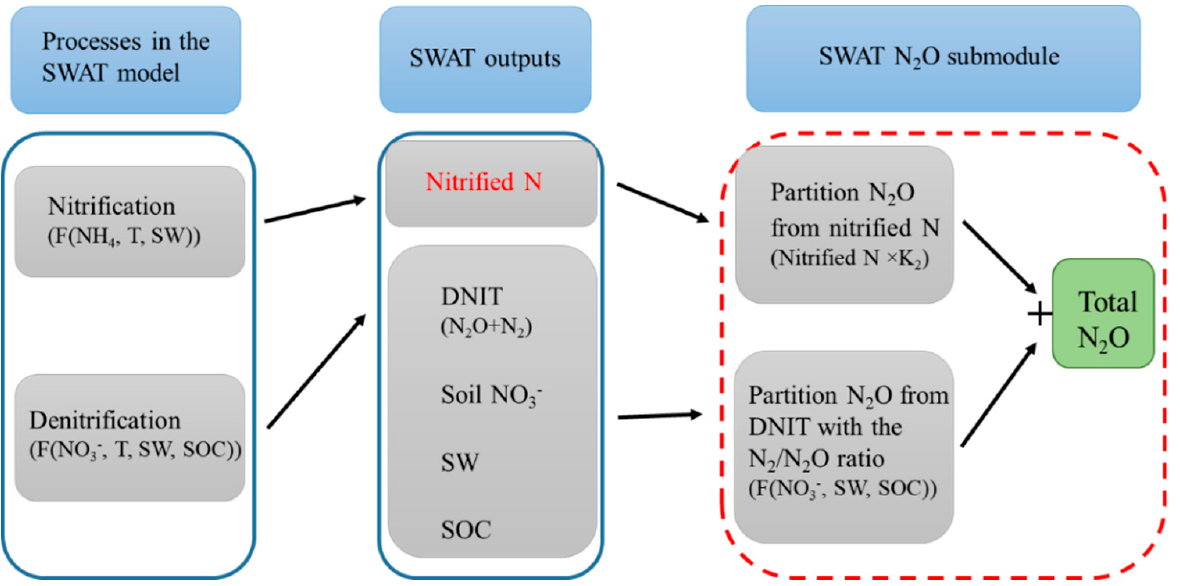
Figure 2. Schematic diagram of the processes included in the SWAT model and the SWAT N 2 O submodule. Nitrified N in a red color indicates the SWAT model simulates the nitrified N but can only be examined in the output file after the SWAT source codes were modified. Abbreviations: F: function. T: soil temperature. SW: soil water. SOC: soil organic carbon. DNIT: denitrification. K 2 : the fraction of nitrified N lost as N 2 O.